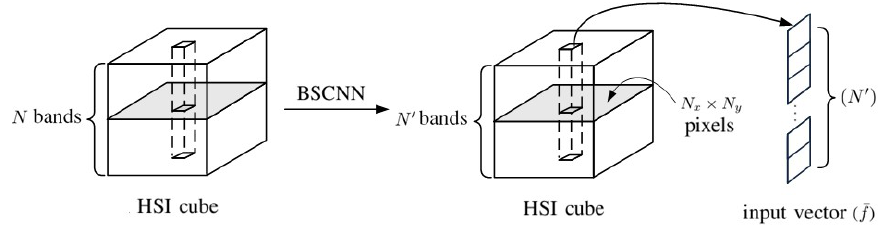
Figure 7. Input vectors to the